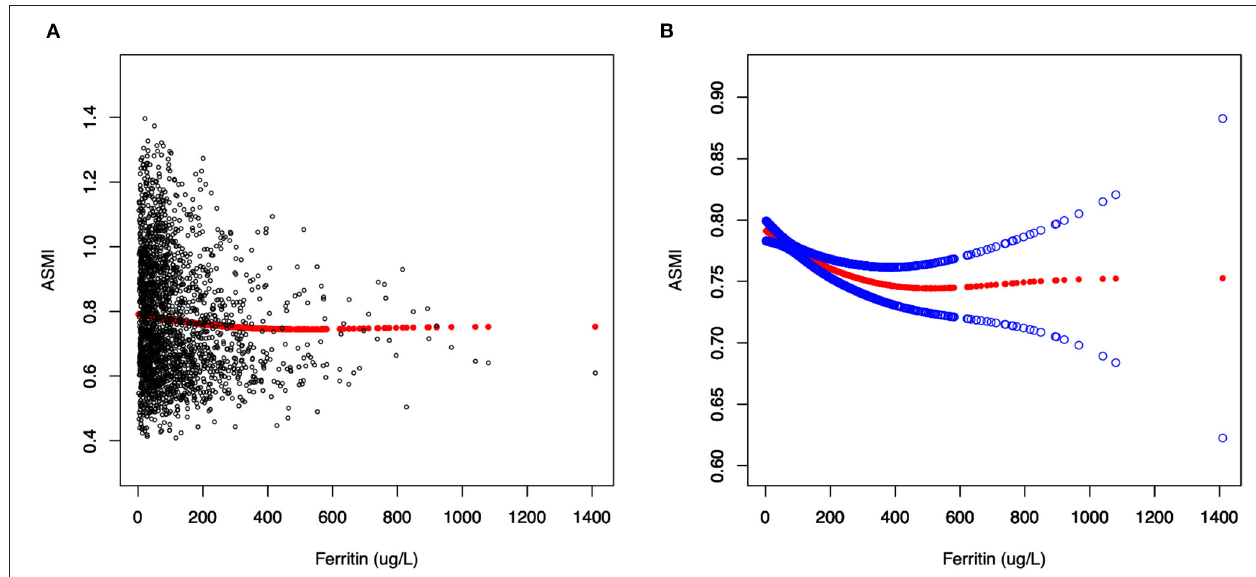
FIGURE 2 | The relationship between serum ferritin and muscle mass. (A) Each black point represents a sample. (B) Solid red line represents the smooth curve fit between variables. Blue bands represent the 95% of confidence interval from the